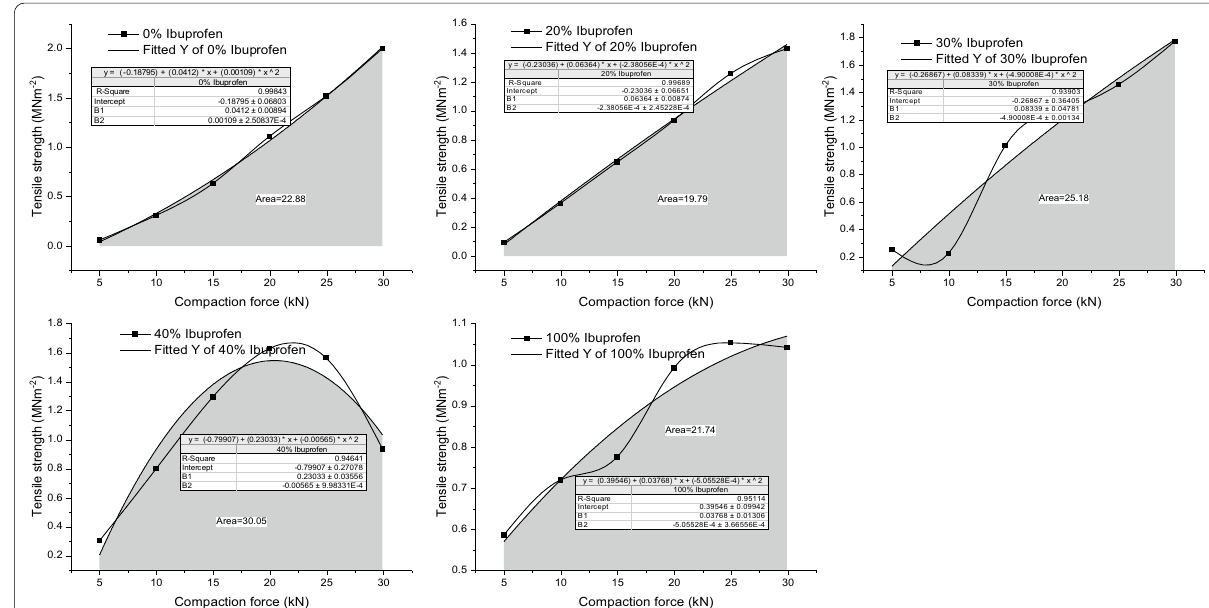
Fig. 4 Area under the tensile strength–compaction force curve for orodispersible α-lactose-starch diluent. Tensile strength computed according to the Pitt and Heasley (2013) model